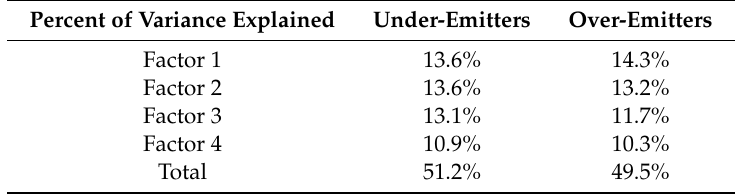
Table A2. Rotated factor analysis: percent of variation explained for those in poverty. Percent of Variance Explained